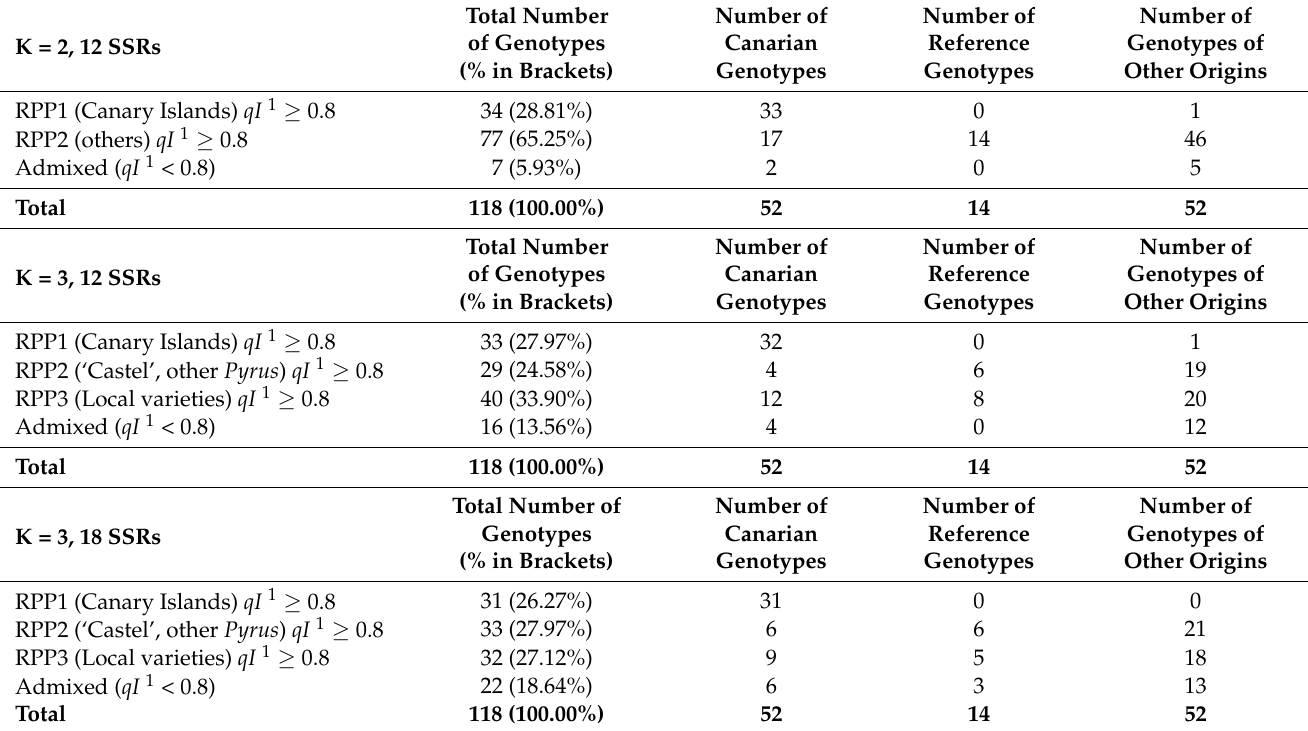
Table 5. Classification of 118 triploid pear genotypes for K = 2 and K = 3 reconstructed populations (RPPs) according to STRUCTURE [35] for the total study